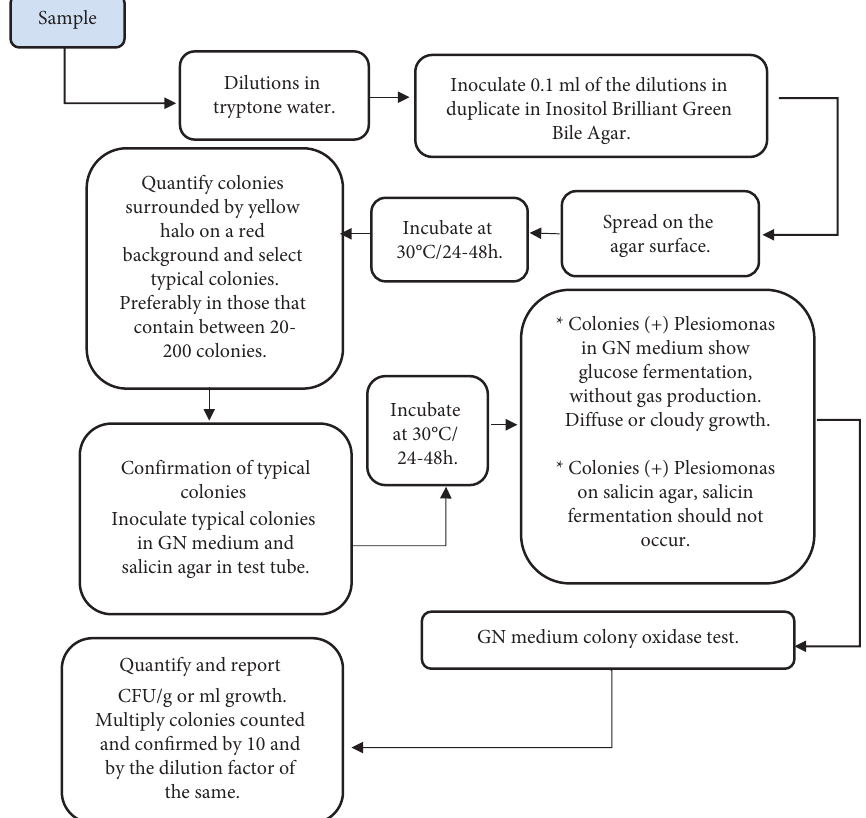
Figure 1: Direct plaque quantification of Plesiomonas in food samples [75]. ∗ GN medium consists of 3 layers of approximately 2cm each, placed in a sterile culture tube. The bottom layer is bile and red violet glucose agar. The middle layer is agar-water, and the top layer is sulfide indole motility (SIM) agar. ∗ Glucose fermentation in positive GN medium (turning of the bile and red violet glucose agar medium in the lower layer of the tube). ∗ P. shigelloides is SH 2 - and indole-positive, but these characteristics are not shown in GN medium. ∗ In GN medium, the mobile species develop, forming diffuse growth along the inoculation streaking line or more intense